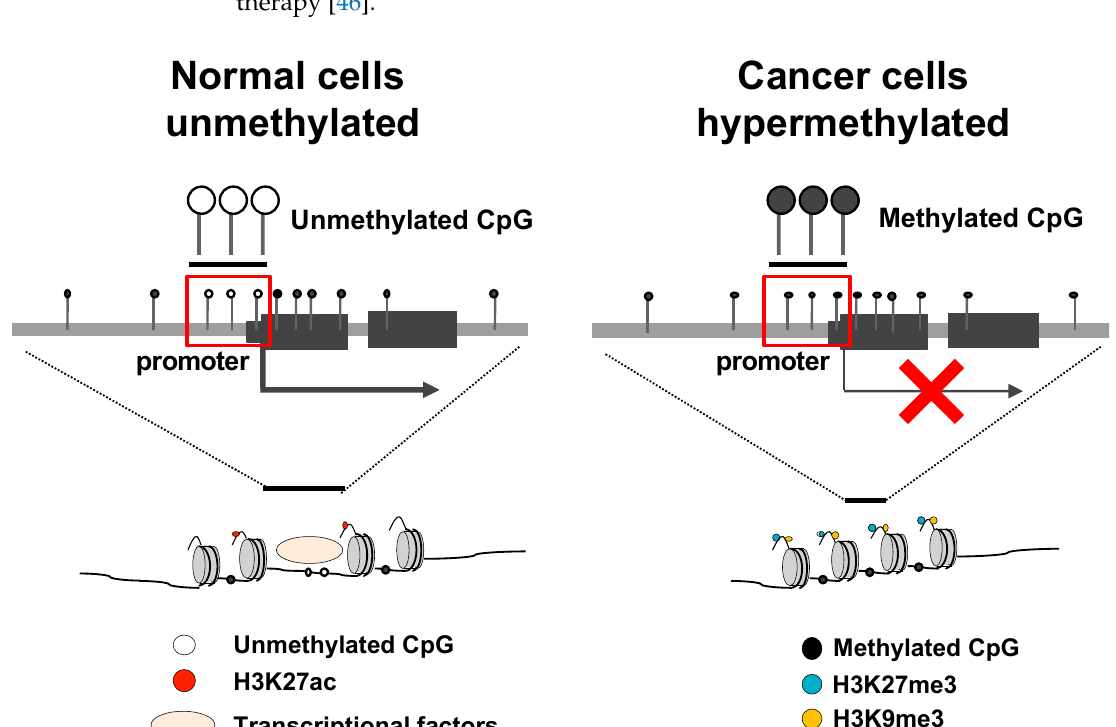
Figure 1. Transcriptional repression by promoter DNA hypermethylation and histone modifications. In normal cells, the CpG islands of promoter regions are open chromatin and generally unmethylated. Gene transcription is activated by transcriptional factors with H3K27ac ( left ). In cancer cells, the CpG islands in the promoter regions are hypermethylated, constructing heterochromatin with H3K27me3 and H3K9me3, which suppresses gene transcription ( right ). Abbreviations: H3K27me3, trimethylation of lysine 27 on histone 3; H3K9me3, trimethylation of lysine 9 on histone 3; H3K27ac, acetylation of lysine 27 on histone 3.